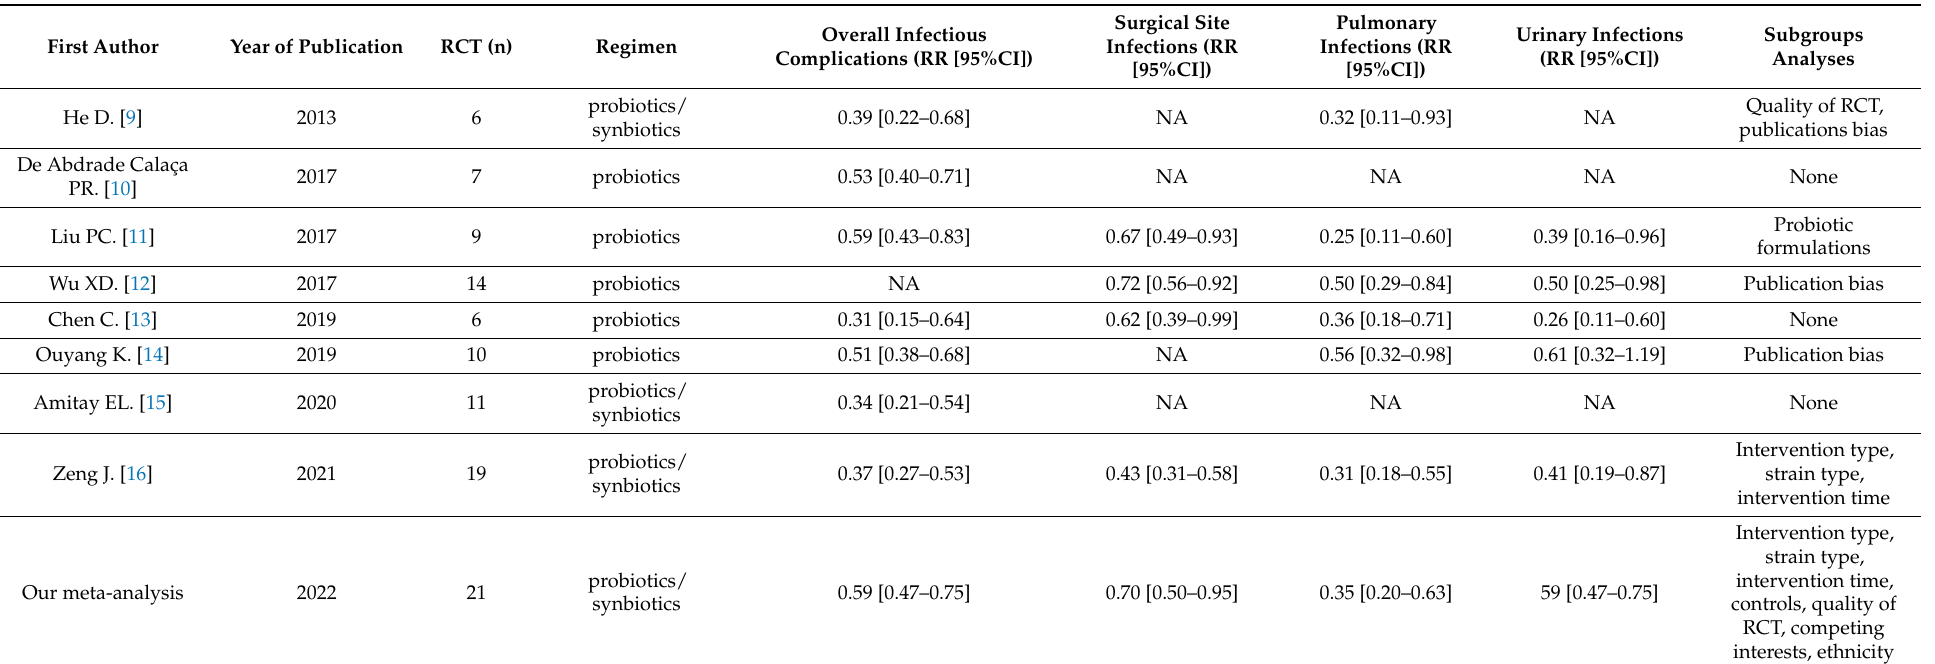
Table 4. Characteristics and results of published meta-analyses focusing on colorectal surgery and our own meta-analysis